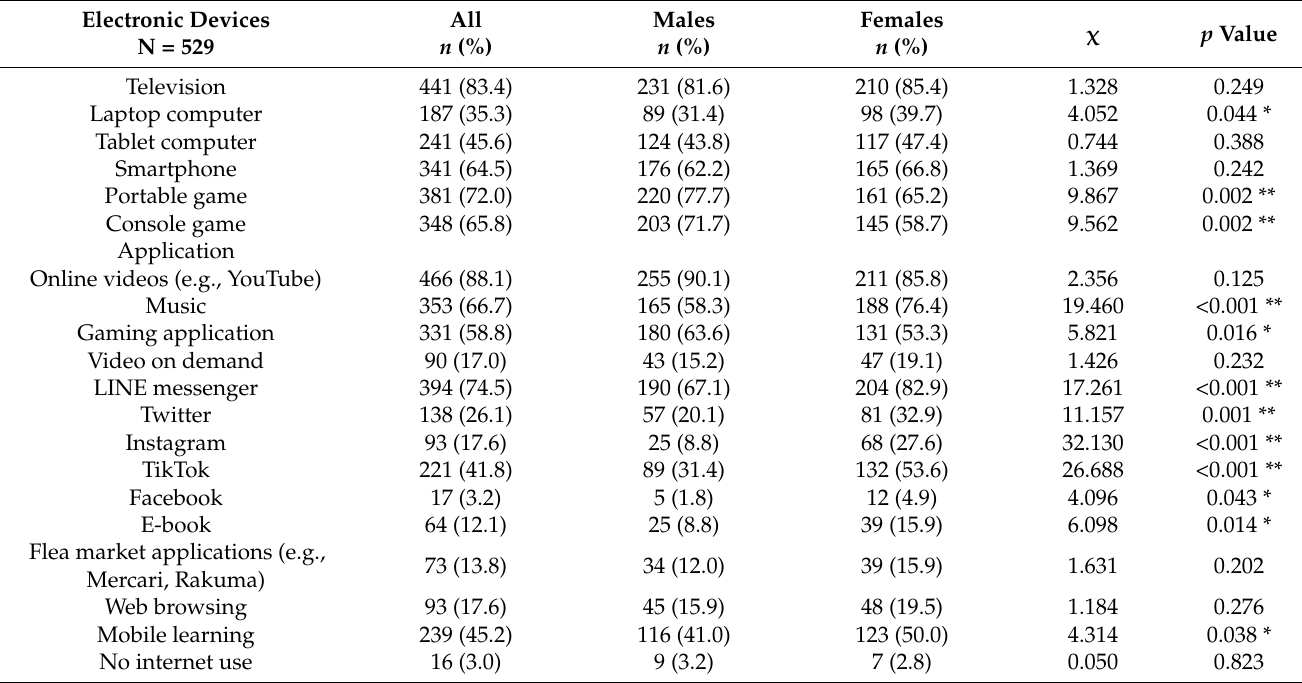
Table 2. Characteristics of students according to accessibility of electronic devices and applications